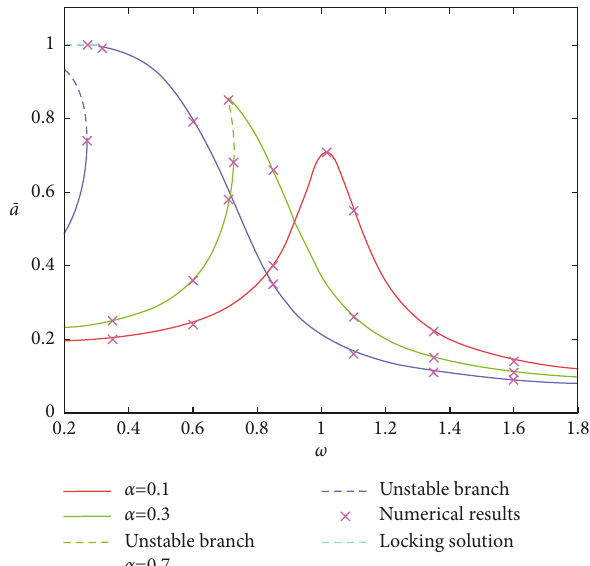
Figure 6: Amplitude-frequency responses under positive values of � 0 . α for f 0